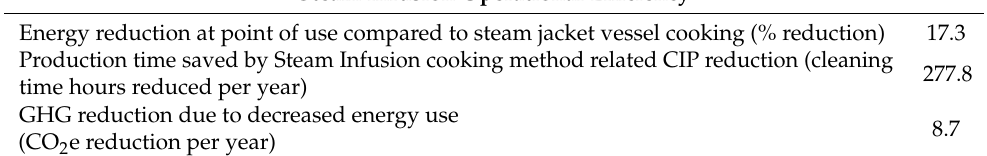
Table 1. The efficiency of Steam Infusion cooking compared to conventional steam jacketed vessel